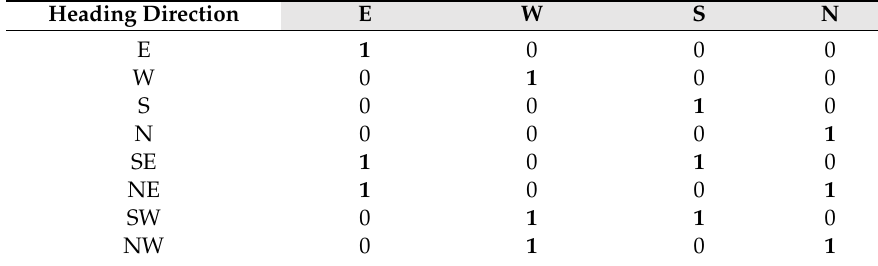
Table 2. Estimation of the representative heading direction of the connected cars. Heading Direction